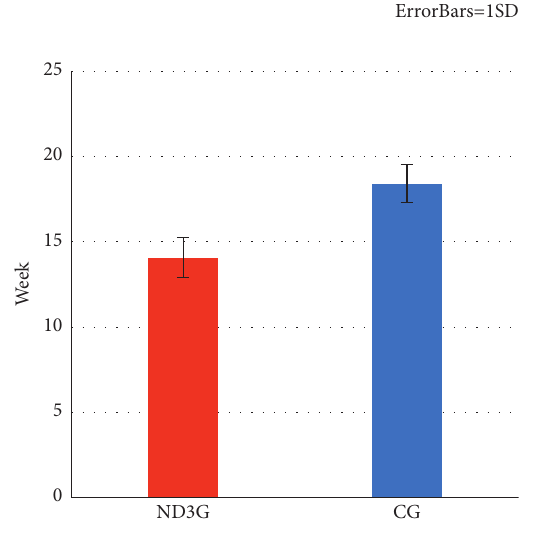
Figure 3: Duration of